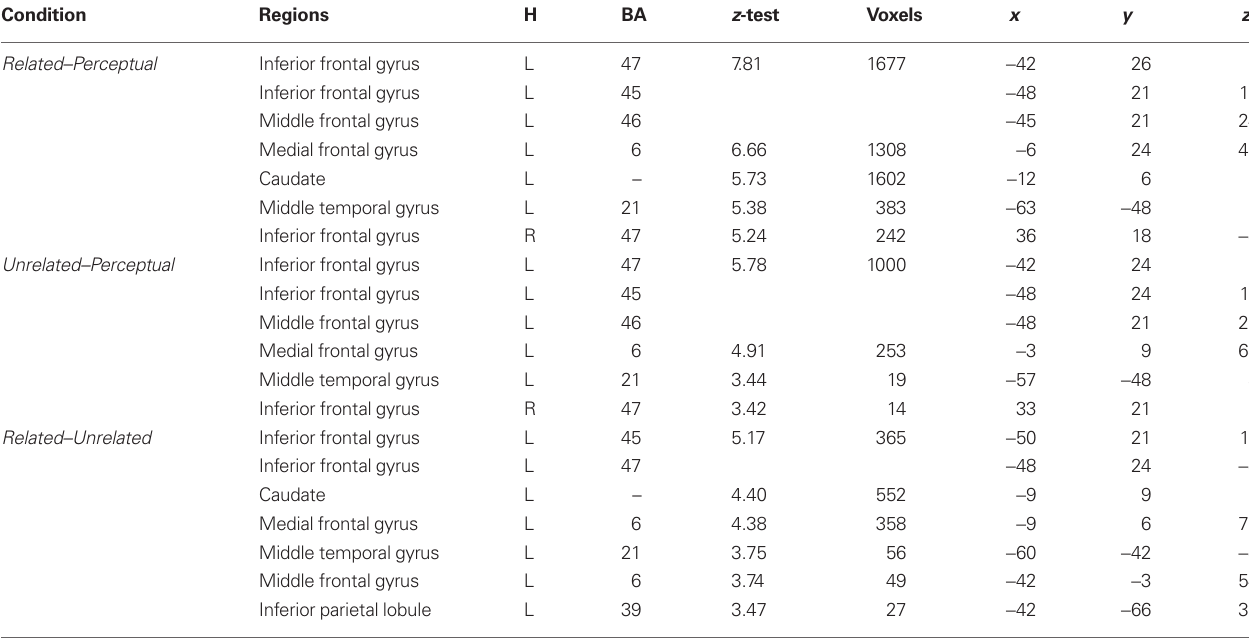
Table 2 | Greater activation for the related or unrelated conditions compared to the perceptual control condition. The direct comparison between the related and unrelated conditions is also presented.